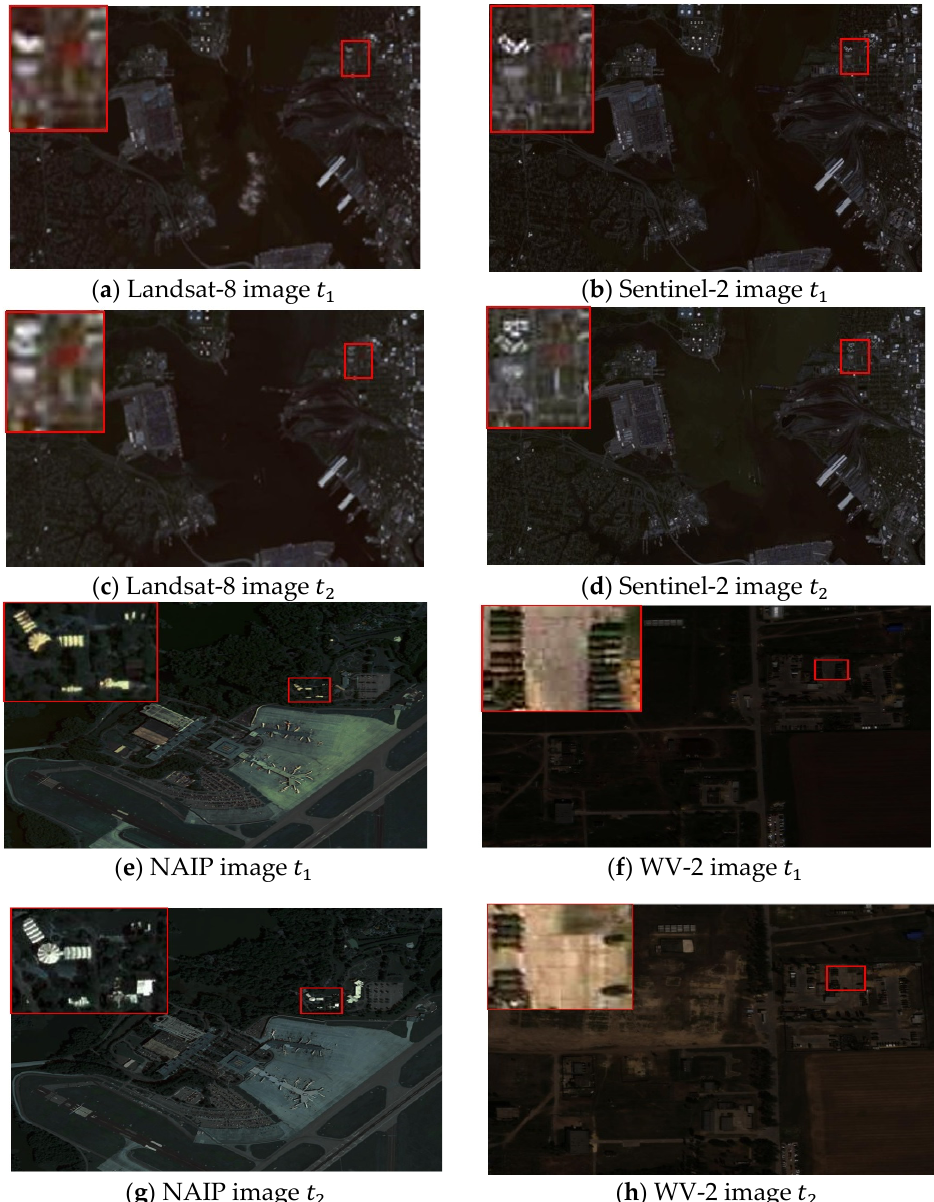
Figure 5. Training image examples. Resolution: Landsat-8 (30 m), Sentinel-2 (10 m), NAIP (1 m), and WV-2 (0.46 m). Large red boxes display zoomed-in regions in the corresponding small boxes. Significant temporal changes can be observed. For example, in Figure 5e, the buildings are under construction and incomplete, whereas in Figure 5g, the buildings are completed. Image contrast was enhanced for better display.